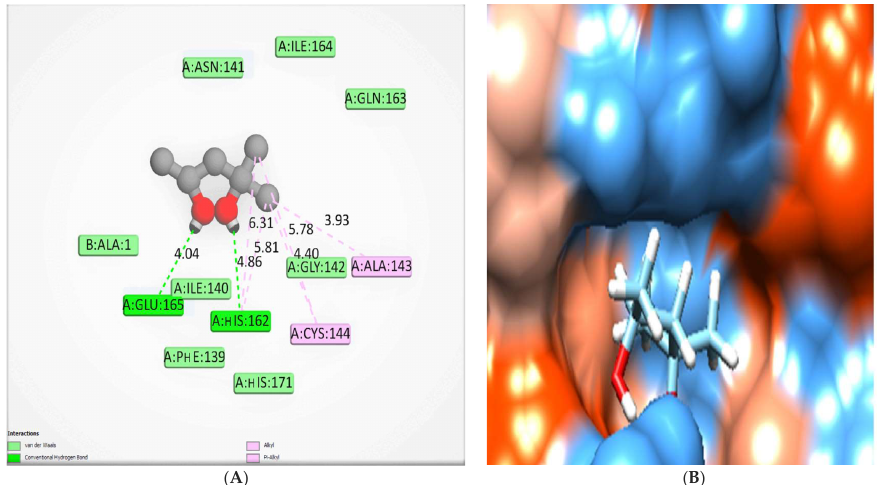
Figure 11. The crystal structure MDP has been re-docked in HCo-V 229E main protease, where hydrogen bonds (green) and pi interactions are represented in pink lines ( A ) with a mapping surface demonstrating the crystal ligand occupying the active pocket of HCo-V229E main protease ( B ) with binding energy −5.66 Kcal/mol.